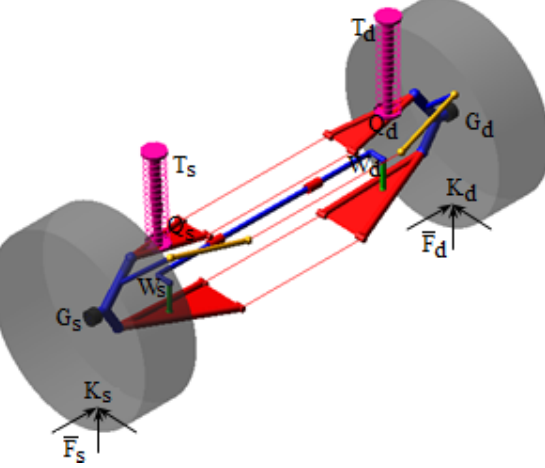
Figure 3. The static model of the non-steered wheels’ suspension system.